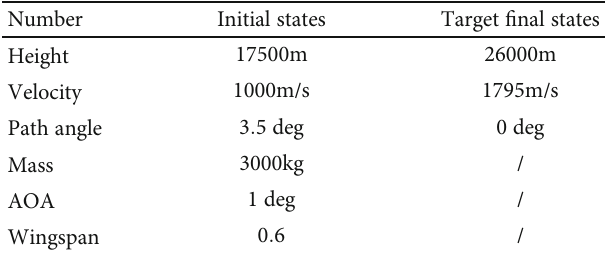
Figure 1: Scheme of AMPI. Table 1: The value of the initial states and target fi nal